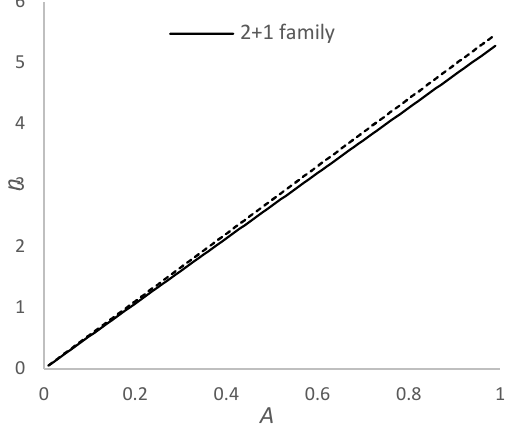
Figure 1. The optimal number of children as a function of A